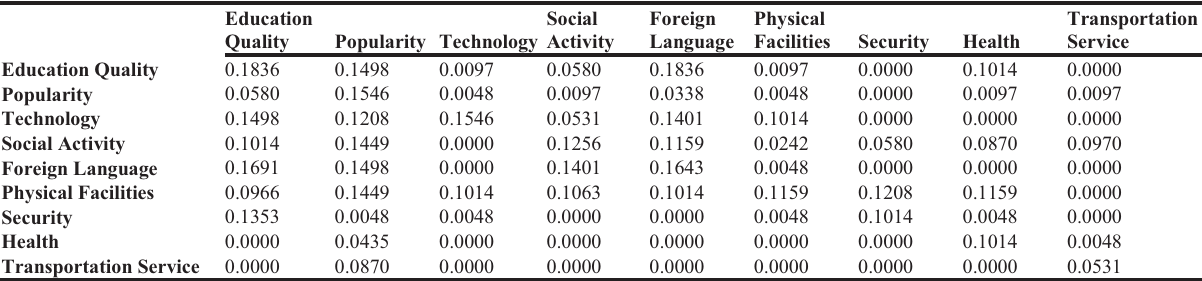
Table 3. Connection matrix composed of weights.